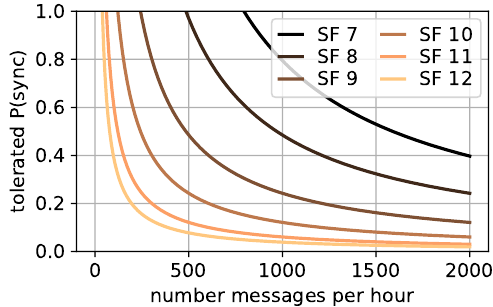
Figure 2. P ( sync ) to messages